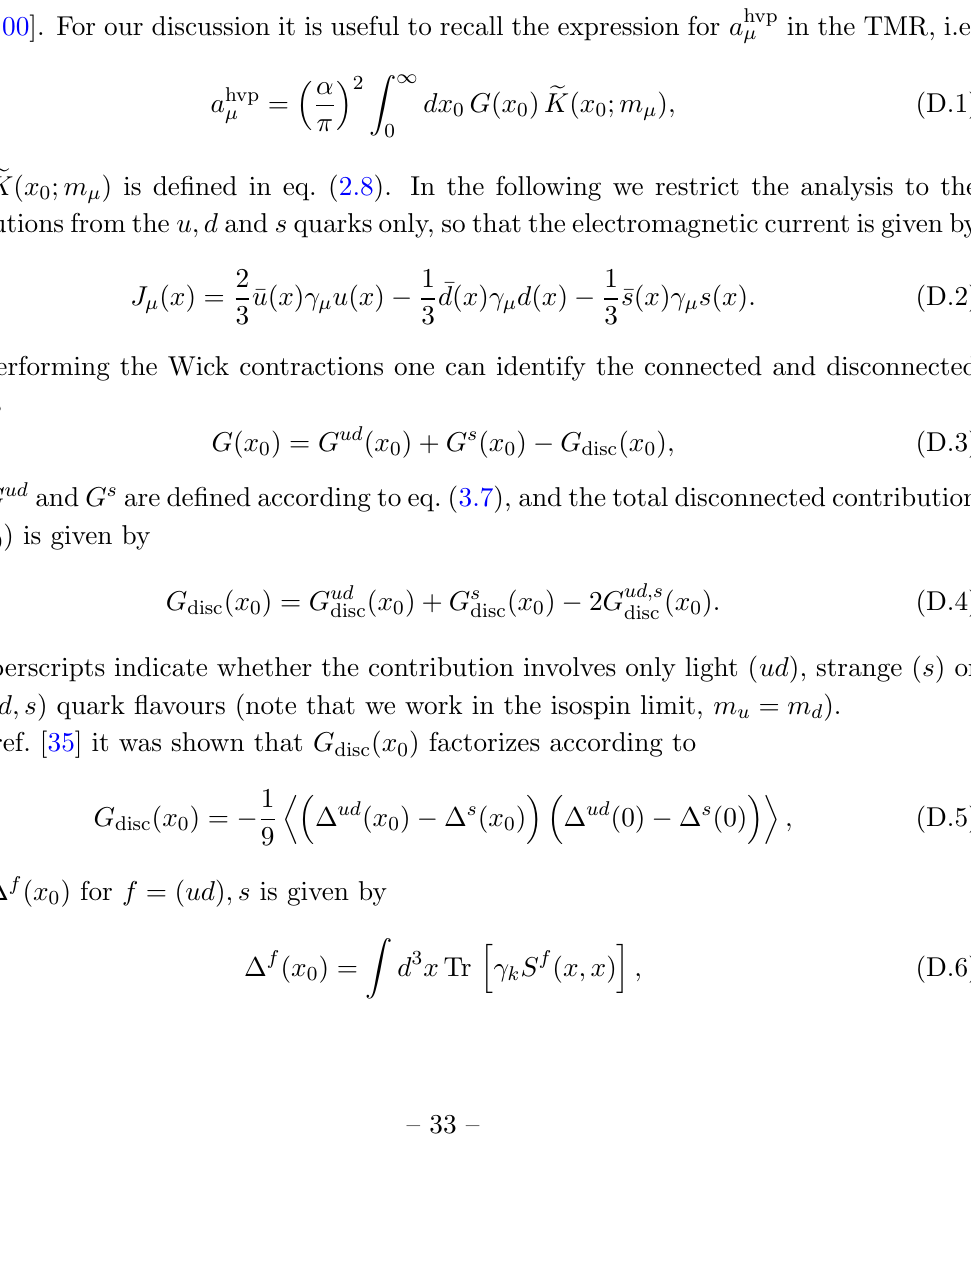
m 2 + (2 (cid:25)=L ) 2 for the ground-state (cid:25) p